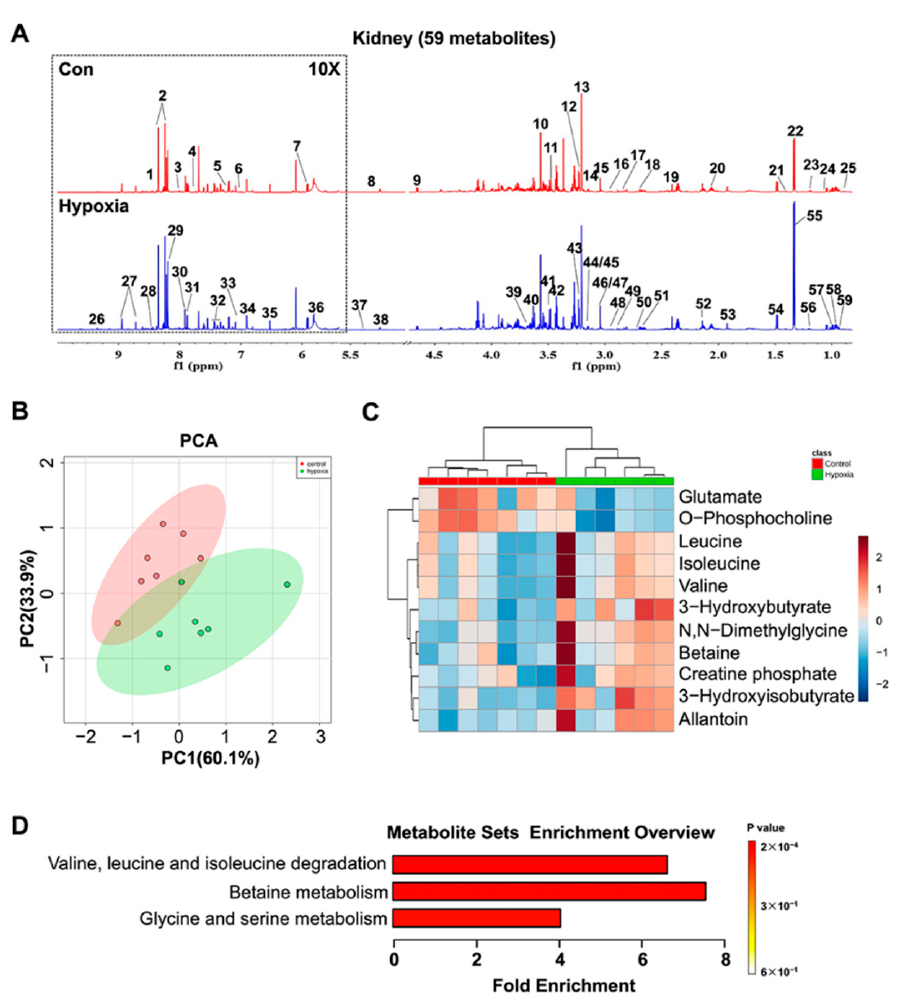
Figure 5. Metabolomic analysis of the kidney. ( A ) Representative 1D 1 H NMR spectra of aqueous extracts derived from the kidney. 1, Inosinic acid; 2, Inosine; 3, 3-Methylxanthine; 4, Tryptophan; 5, Imidazole; 6, Anserine; 7, Uridine; 8, Glucuronate; 9, Glucose; 10, Glycine; 11, Methanol; 12, Betaine; 13, Choline; 14, Ethanolamine; 15, N,N-Dimethylformamide; 16, N-Methylhydantoin; 17, Asparagine; 18, Aspartate; 19, Succinate; 20, Glutamate; 21, 2-Phenylpropionate; 22, Threonine; 23, 3-Hydroxyisobutyrate; 24, 3-Hydroxybutyrate; 25, Pantothenate; 2, Nicotinamide adenine dinucleotide; 27, Niacinamide; 28, Formate; 29, Adenine; 30, Xanthine; 31, 4-Pyridoxate; 32, Phenylalanine; 33, Histamine; 34, Tyrosine; 35, Fumarate; 36, Uracil; 37, Allantoin; 38, Mannose; 39, Glycerol; 40, Myo-inositol; 41, Taurine; 42, O-Phosphocholine; 43, Glycerophosphocholine; 44, Malonate; 45, Cystine; 46, Creatine phosphate; 47, Creatinine; 48, N,N-Dimethylglycine; 49, Trimethylamine; 50, Dimethylamine; 51, 5,6-Dihydrouracil; 52, Methionine; 53, Acetate; 54, Alanine; 55, Lactate; 56, Ethanol; 57, Valine; 58, Leucine; 59, Isoleucine. ( B ) PCA score plot, illustrating the metabolic difference between hypoxic mice and controls. The x -axis represents the first PC accounting for 60.1% of the total variation, and the y -axis denotes the second PC accounting for 33.9% of the total variation. Ovals in the panel highlight the metabolic distinction between two groups. ( C ) Clustered heatmap plot of relative metabolite levels, showing the metabolic derangement. ( D ) Significantly altered metabolitc